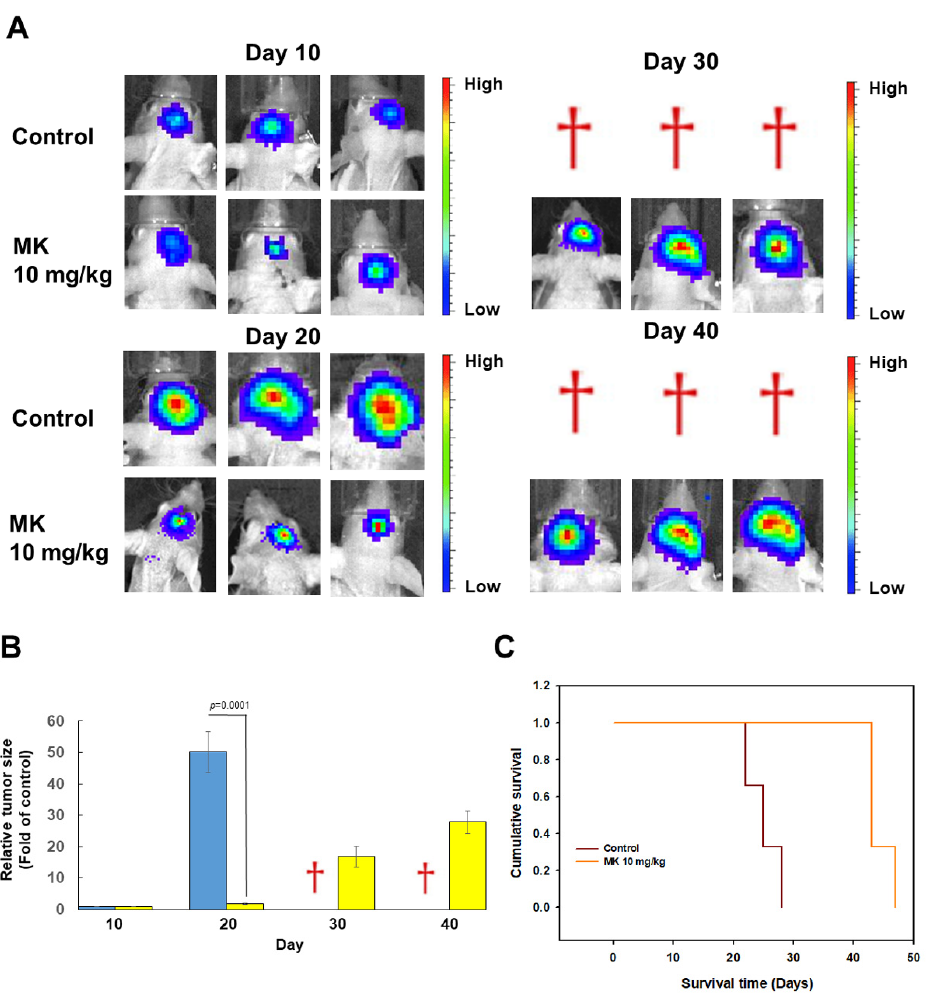
Figure 10. Maackiain (MK) has an obvious antitumor effect, as shown by biophotonic measurement of orthotopic xenografts in immunodeficient mice. Male BALB/c nude mice were intracranially infused with 4 × 10 5 firefly luciferase-labeled U87MG (U87-luc) glioma cells. Mice were divided into groups treated with normal saline (control) or 10 mg/kg MK with n = 3 per group. After 10 days, 13 days, and 16 days, mice were injected with normal saline or MK (10 mg/kg). ( A ) Bioluminescence imaging of GBMs was performed after 10, 20, 30, and 40 days of tumor cell implantation and is shown as a function of total radiance in photons/s/cm 2 per steradian. Tumor burden is revealed by a colorimetric scale where red represents the highest range of radiance values, which translates to tumor burden. Red daggers represent death of the animal. ( B ) Radiation values from GBM-bearing mice in control and MK-treated groups in panel A were averaged and compared. ( C ) MK treatment extended the overall lifespan of GBM-bearing mice. Kaplan–Meier curves are compared between the control and MK-treated